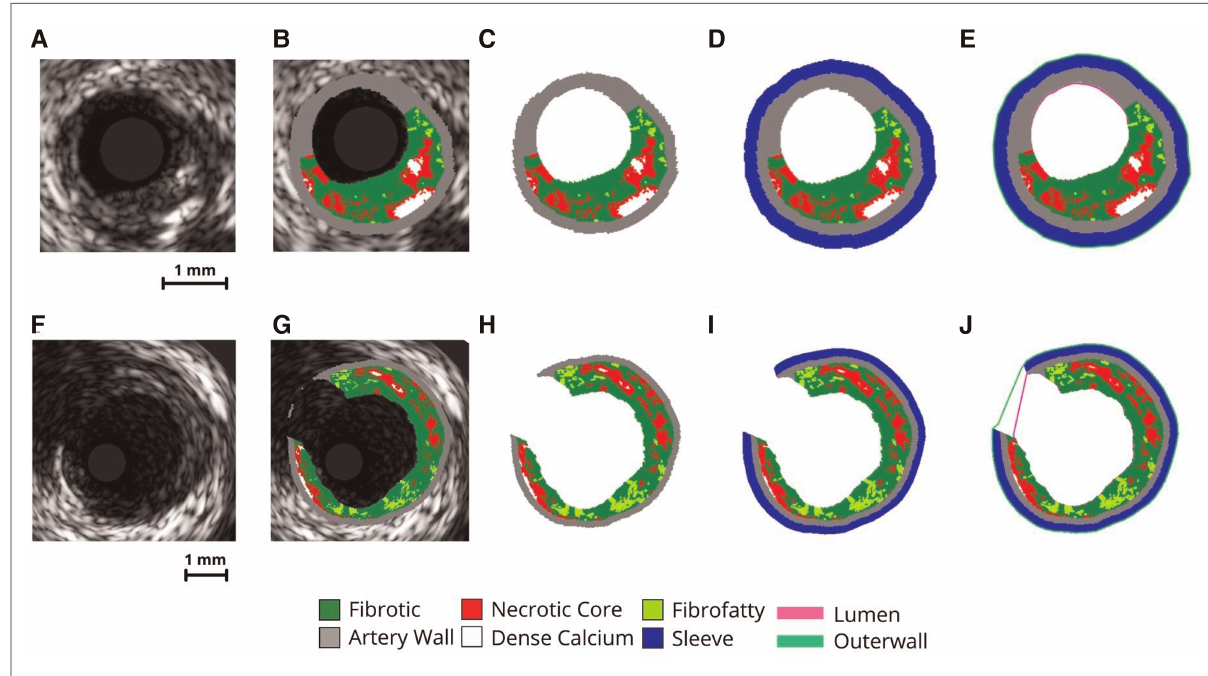
FIGURE 3 VH-IVUSimagingprocessing procedure. Imageprocessingsteps of VH-IVUS images with ( F-J ) and without ( A-E ) a bifurcation. ( A,F )raw IVUSimages.( B,G ) VH overlay on the raw IVUS image. ( C,H ) image after extracting plaque constituent pixels. ( D,L ) image after adding sleeve layer. ( E,J ) Image after extracting inner (lumen) and outer surface pro fi